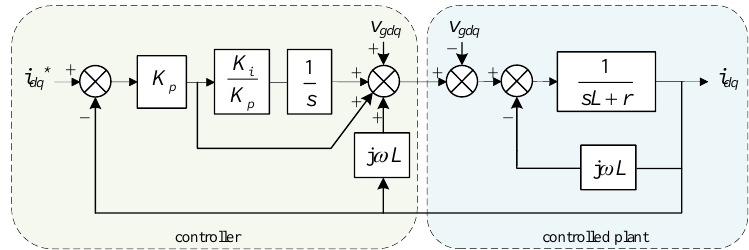
Figure 4. Complex vector block diagram of the inverter with a cross-coupling decoupling synchronous frame PI current controller, shown in the synchronous reference frame.